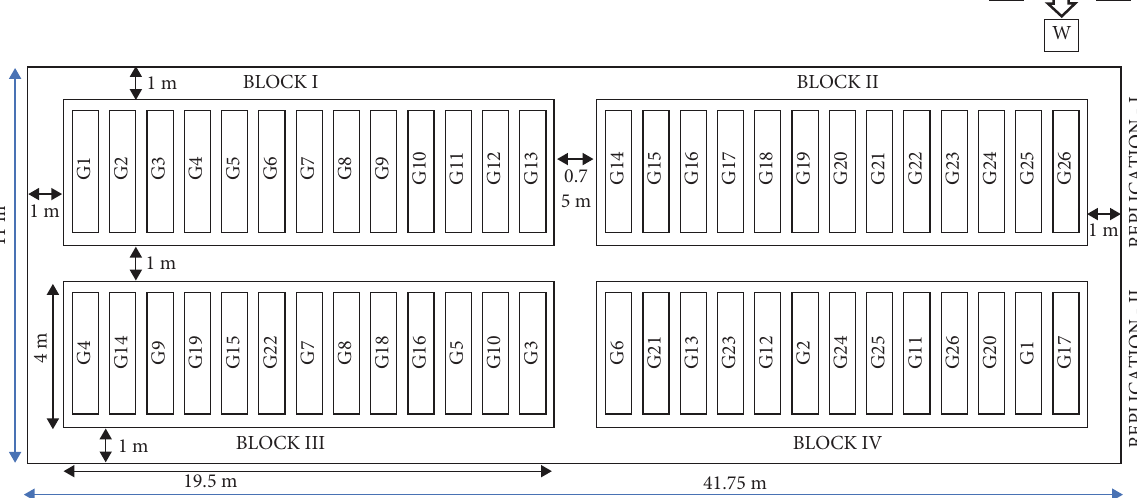
Experimental Layout showing block, replications and genotypes